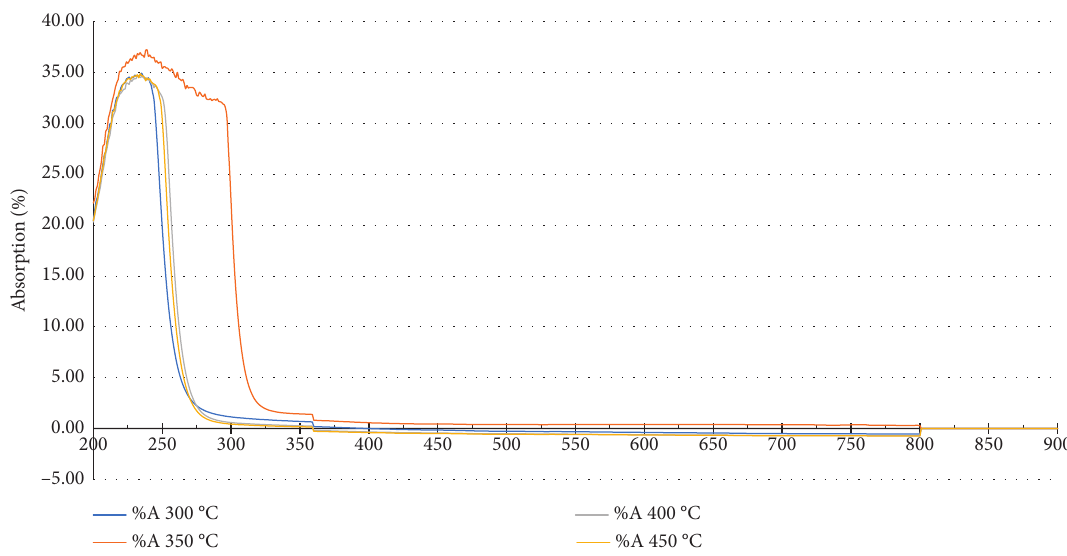
Figure 10: The absorption of SnO 2 films with different calcination temperatures.